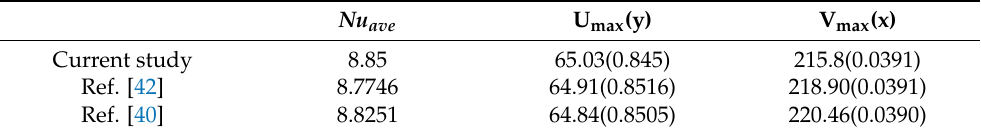
Table 2. Quantitative comparison of Nusselt number and the maximum velocity location and magnitude. The values in parentheses are locations of maximum velocity measured from the cavity center.